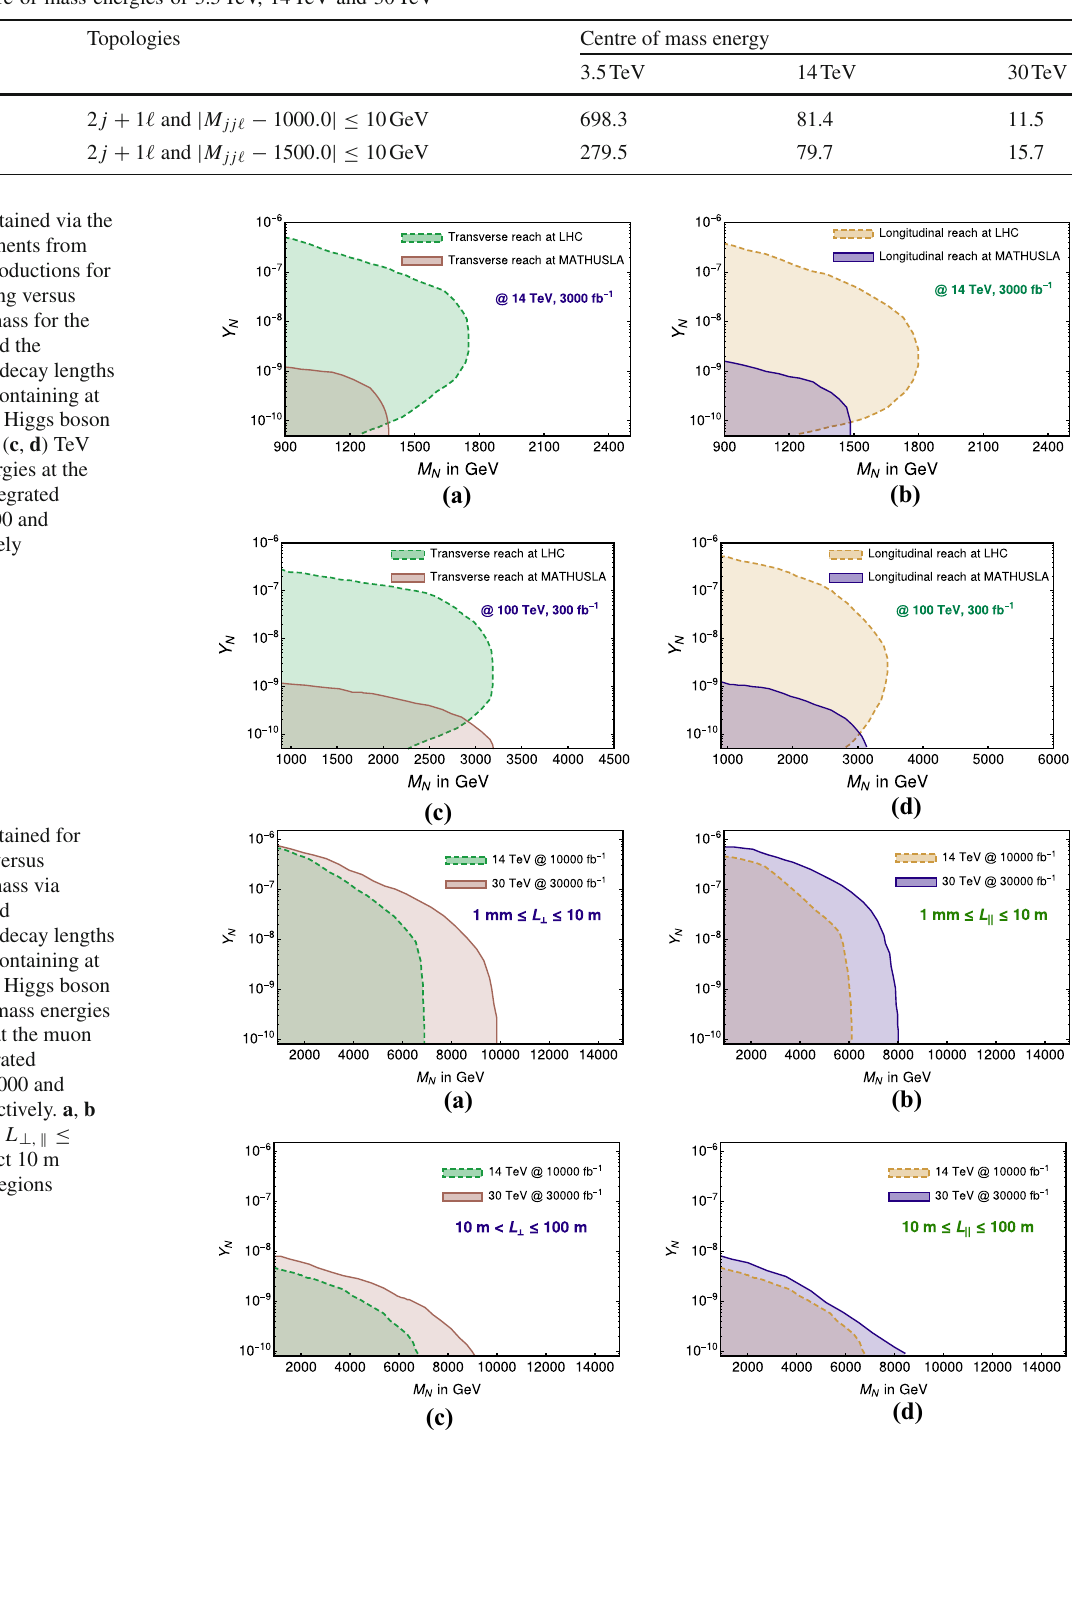
Table 17 The number of events in M jj (cid:5) distribution after the window cut around the mass peak for the benchmark points at the muon col- lider with the centre of mass energies of 3.5TeV, 14TeV and 30TeV